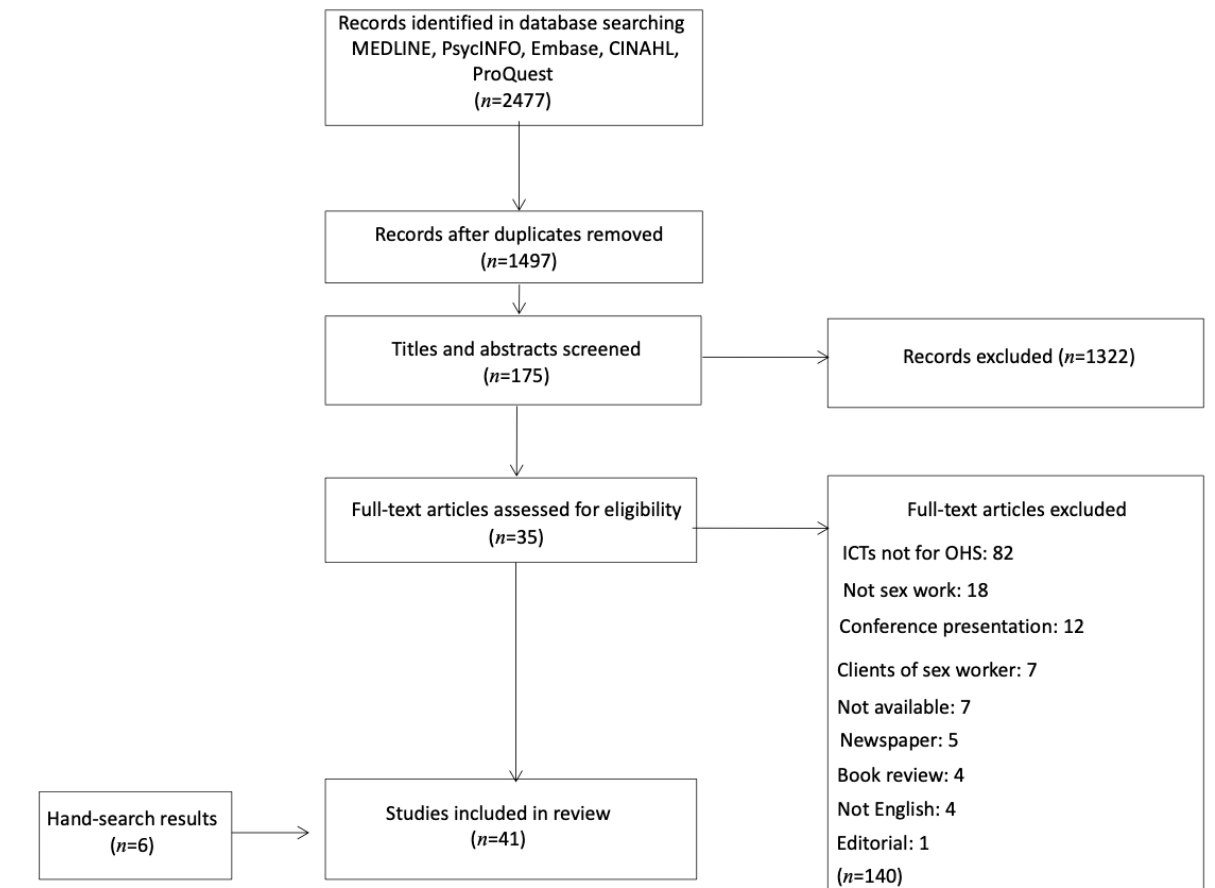
Figure 1. Preferred Reporting Items for Systematic Reviews and Meta-Analyses flowchart. ICT: information and communication technology; OHS: occupational health and